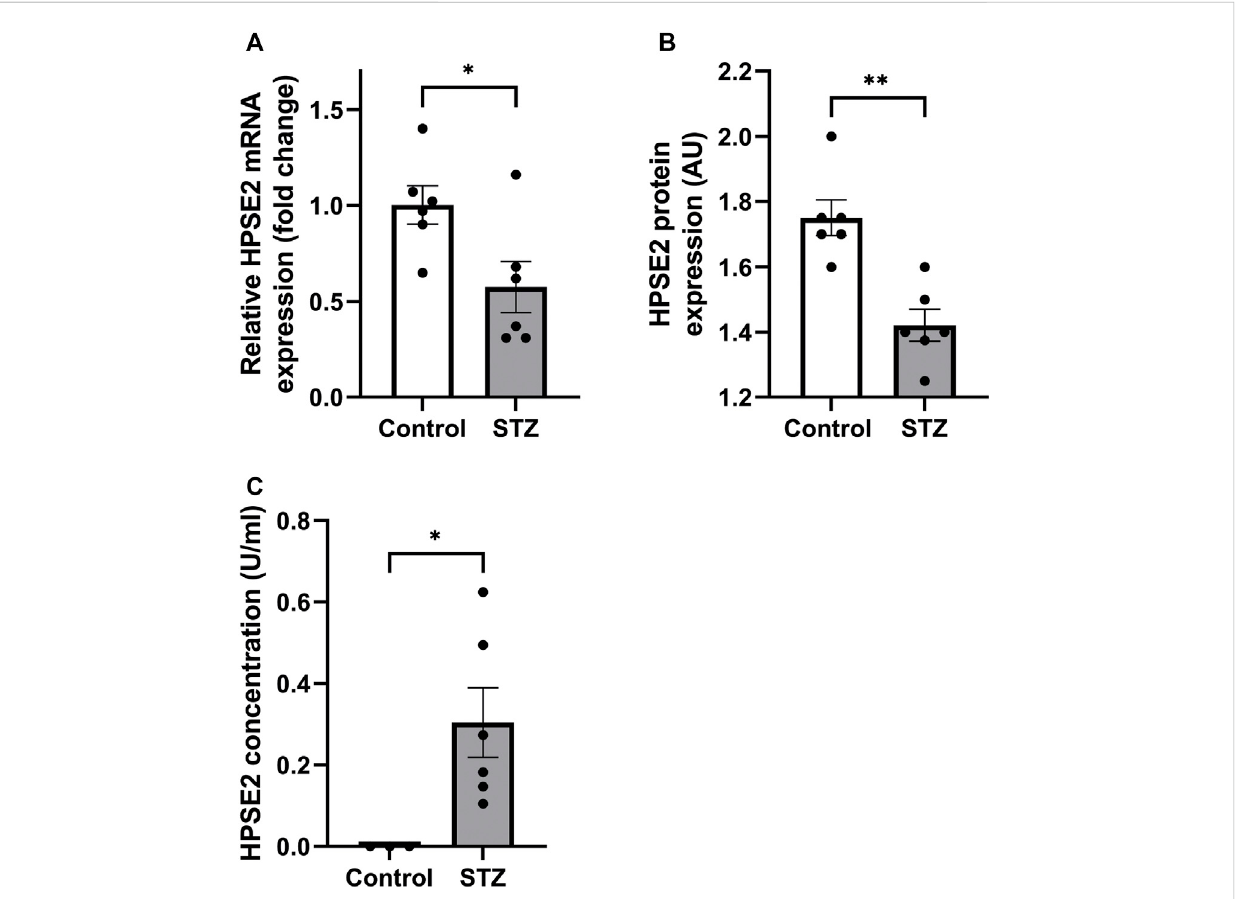
FIGURE 2 HPSE2isdownregulatedinexperimentaldiabeticnephropathy (A) .RenalcorticalHPSE2mRNAexpressionofwild-typeDBA/2Jmicetreatedwithor without STZ for 16 weeks (B) . Renal cortical HPSE2 protein expression of wild-type mice treated with or without STZ for 16 weeks (C) . HPSE2 concentration in urine of wild-type mice treated with or without STZ for 16 weeks. Data are expressed as mean ± SEM. n ≥ 3 * p < 0.05, ** p < 0.01. HPSE2, heparanase-2; AU, arbitrary units; STZ,